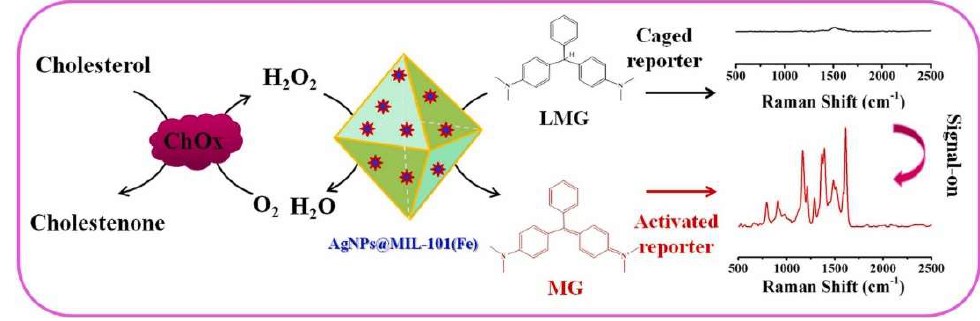
Figure 4. Illustration of the AgNPs@MIL-101 (Fe)-based SERS biosensor to detect cholesterol (Reprinted with permission from Ref. [47]. Copyright 2022, Elsevier).